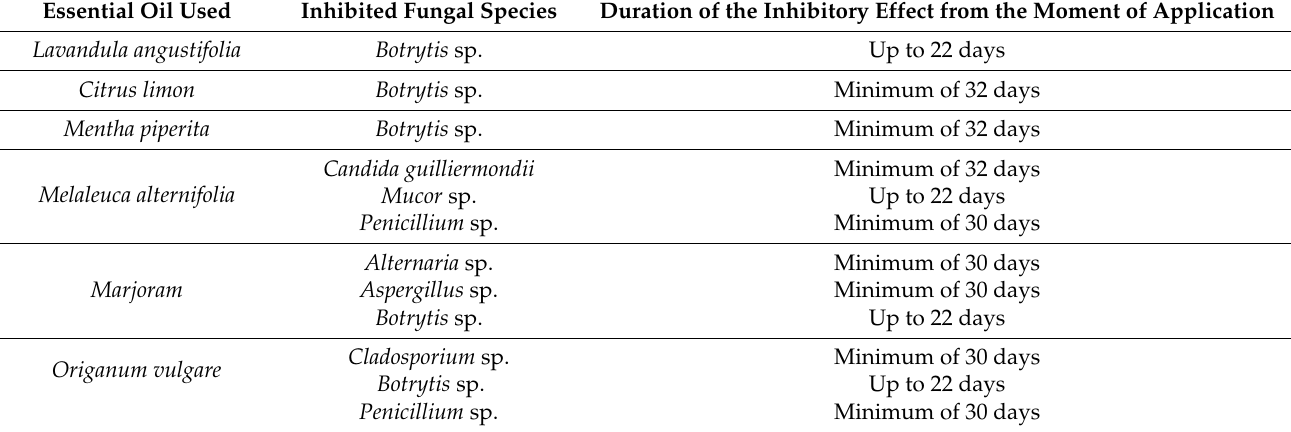
Table 4. Fungal species inhibited by tested essential oils and the tested duration of their inhibitory effect. Essential Oil Used Inhibited Fungal Species Duration of the Inhibitory Effect from the Moment of Application Lavandula angustifolia Botrytis